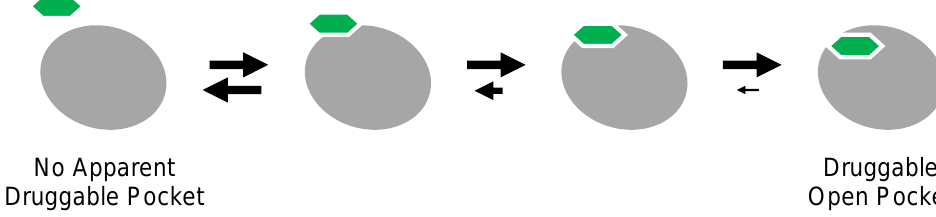
Figure 7. Graphical representation of cryptic binding sites. A small molecule (green) approaches the protein surface (gray). Interactions between the small molecule and the protein alter the sur- face structure (induced-fit), a binding-competent surface conformation of the thermodynamically fluctuating protein structure is caught by the small molecule (conformational selection), or a mixed mechanism underlies the interaction. Small molecule binding consequently reveals a hidden pocket on the protein surface.